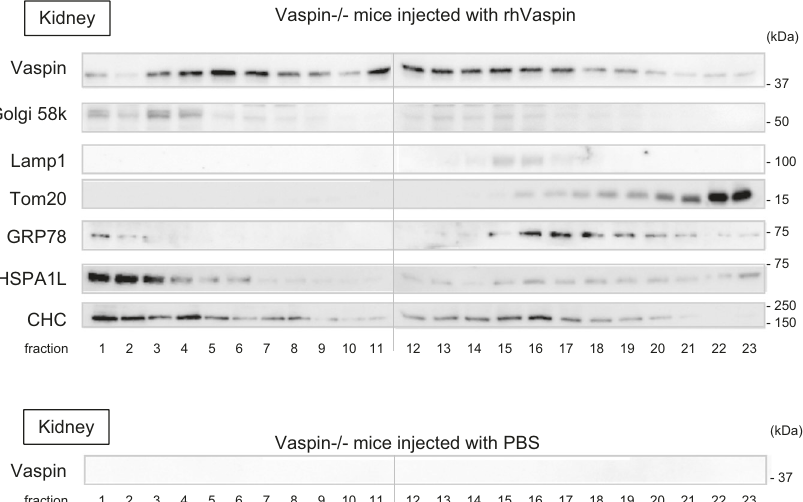
Fig. 9 Cellular localization of rhVaspin injected into Vaspin − / − mice. rhVaspin or PBS as a control were intraperitoneally injected into Vaspin − / − mice, and after 30 min, kidney samples were collected. Kidney tissues were ultra-centrifugated and fractionated by discontinuous iodixanol gradients method. We loaded the fractionated samples #1 to #23 on 2 separate SDS-PAGE gels and performed Western blot analysis. Two polyvinylidene fl uoride membranes, fractions #1-#11 and #12-#23, were placed in this fi gure. rhVaspin protein was localized in throughout subcellular fractions. Western blots were repeated twice.